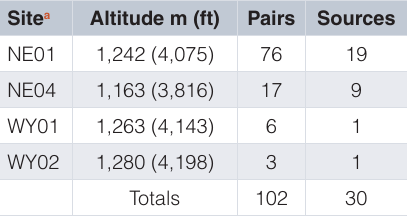
Table 1. Feedlot sites and sources for case-control pairs.